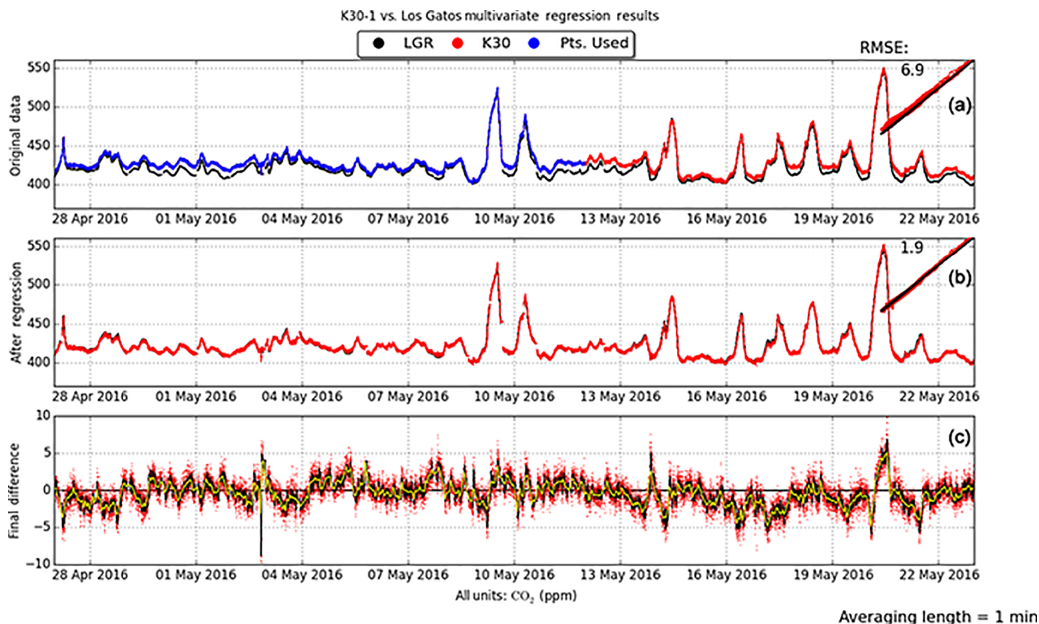
Figure 10. As depicted in Fig. 8, a continuous time series as well as scatter plots for K30-1 compared to the LGR for the multivariate regression described in Sect. 5.2. (a) The original data, (b) final time series after correction and the (c) difference plot between the corrected K30 dataset and the original LGR dataset. However, this regression only includes the first 15 days of data (regression training data in blue, the entire dataset in red) to compute the correction coefficients. The difference plot (c) also shows running means for 10min (black) and hourly (yellow)